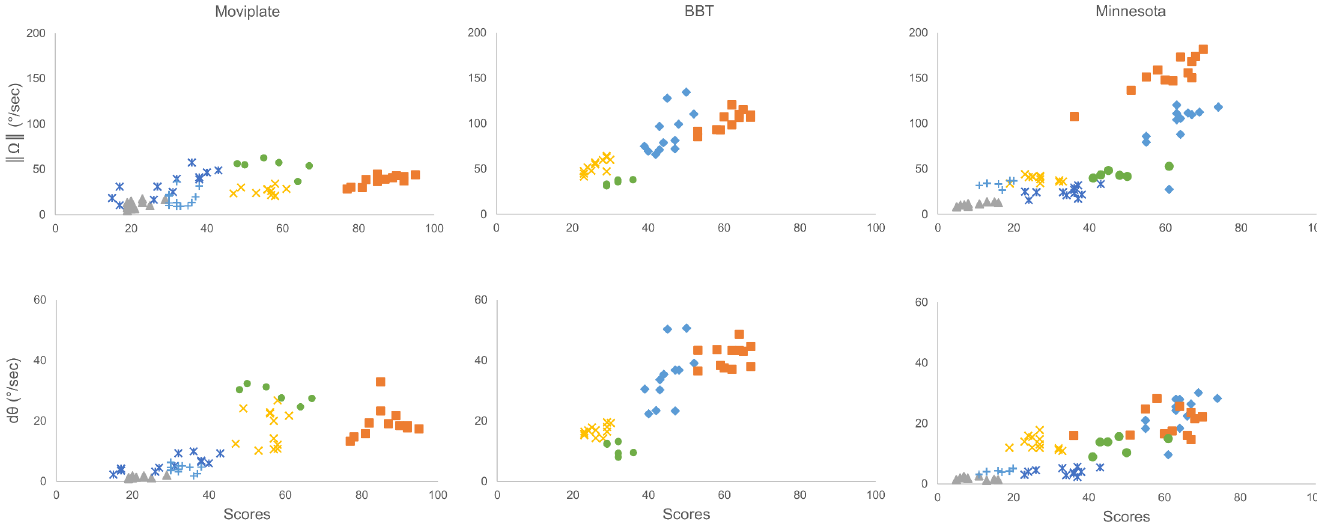
Fig 4. Correlation between the ActiMyo 1 variables and the functional tests ’ scores. ◆ Patient 1; ■ Patient 2; ▲ Patient 3; × Patient 4; ✱ Patient 5; ● Patient 6; + Patient 7. Correlations between k Ω k and scores for the tasks (A) Moviplate, (B) Box and Block test, and (C) Minnesota. Correlation between d θ and scores for the tasks (D) Moviplate, (E) Box and Block test, and (F) Minnesota.